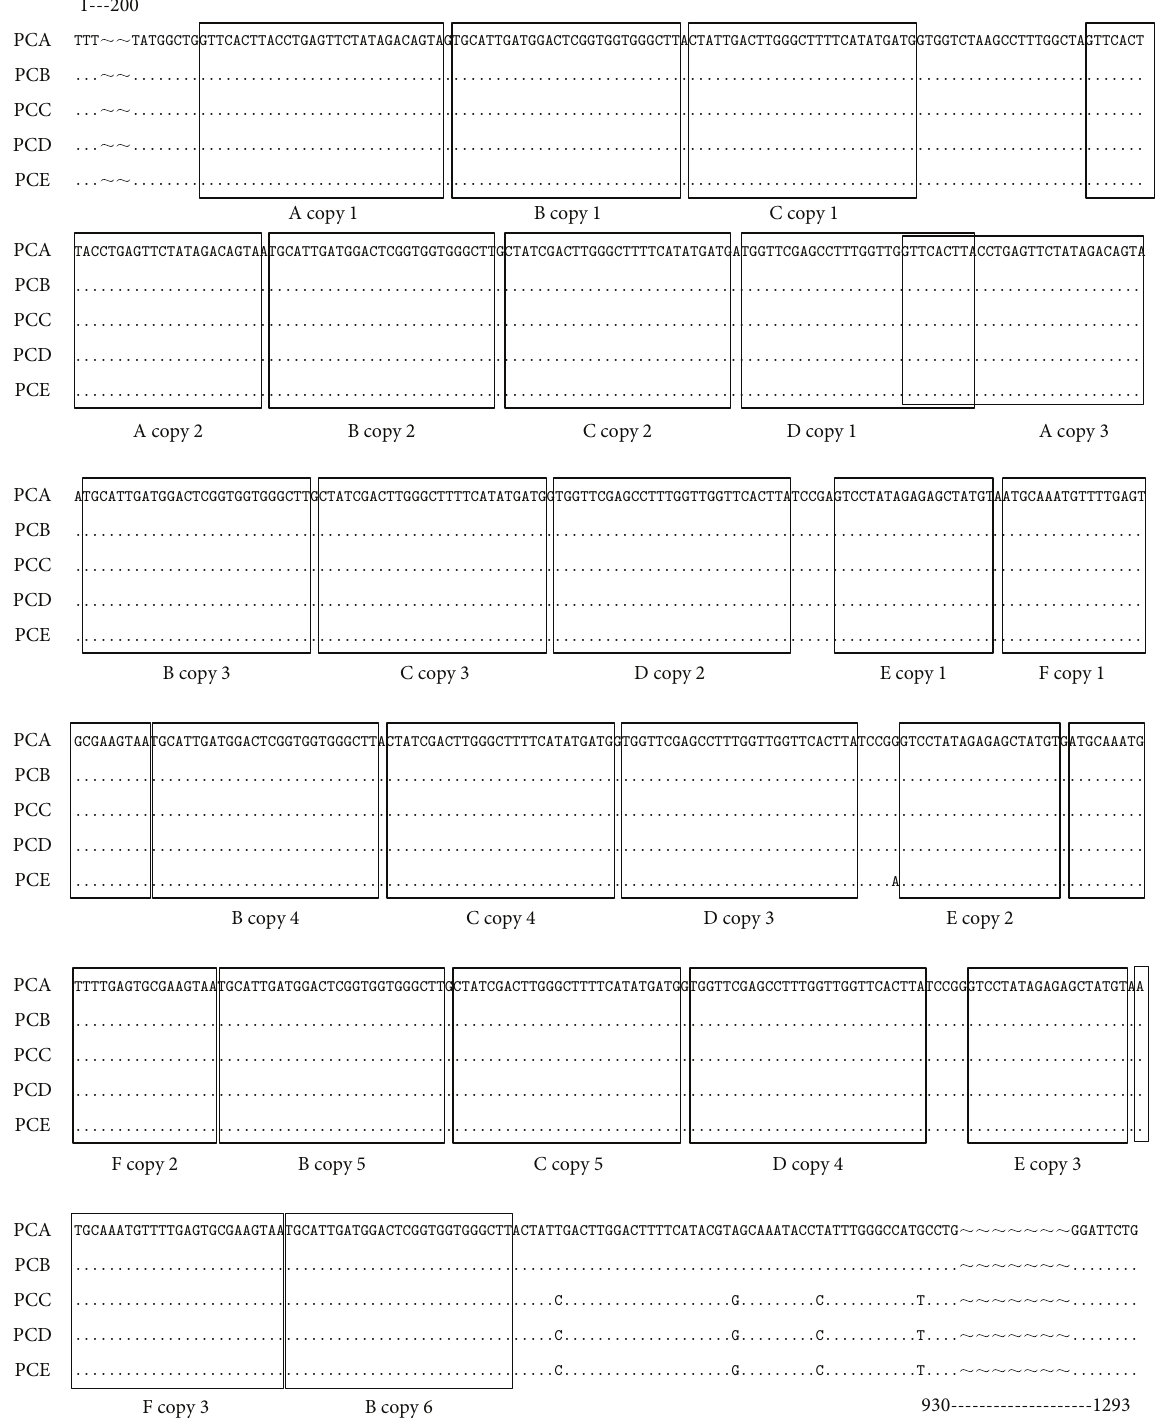
Figure 2: The alignment of ITS1 rDNA region of the five samples of Paramphistomum cervi . Dots denote sequence identity to the first sequence. Dashes represent nucleotide